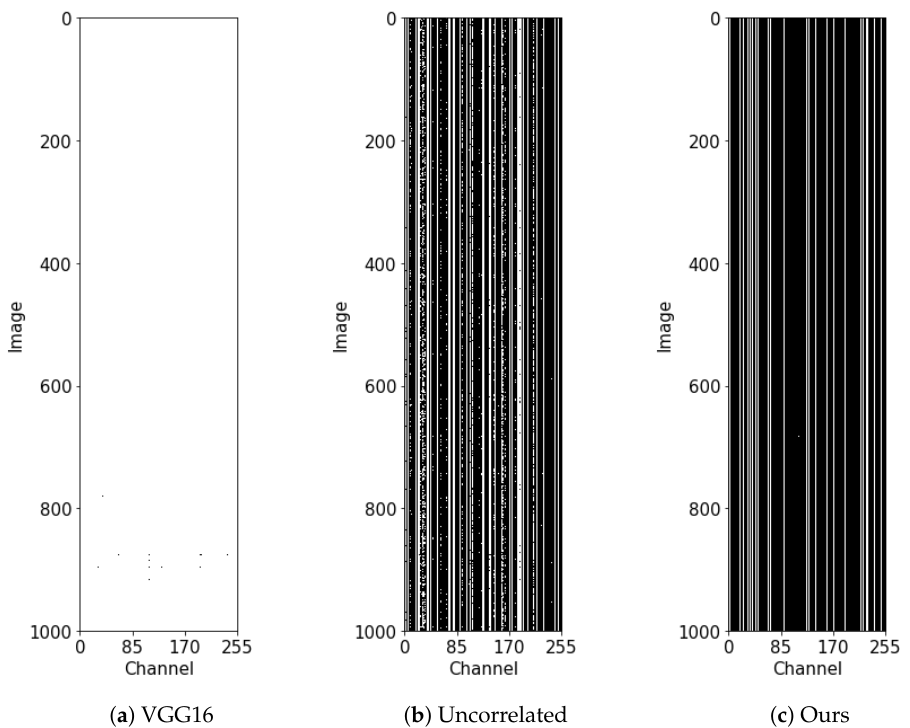
Figure 3. Channel responses of feature maps extracted from 1000 test images: The horizontal and vertical axes represent channel indices and image indices, respectively. The feature map extracted from our pruned network ( c ) shows only 70 non-zero-response channels (white regions) out of a total of 256 channels. Compared to the original VGG16 [9] ( a ) or uncorrelated encoder [42] ( b ), our channel responses show a larger number of consistent zero-response